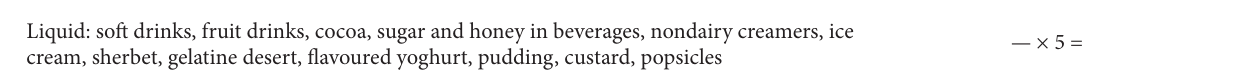
Form Frequency Points